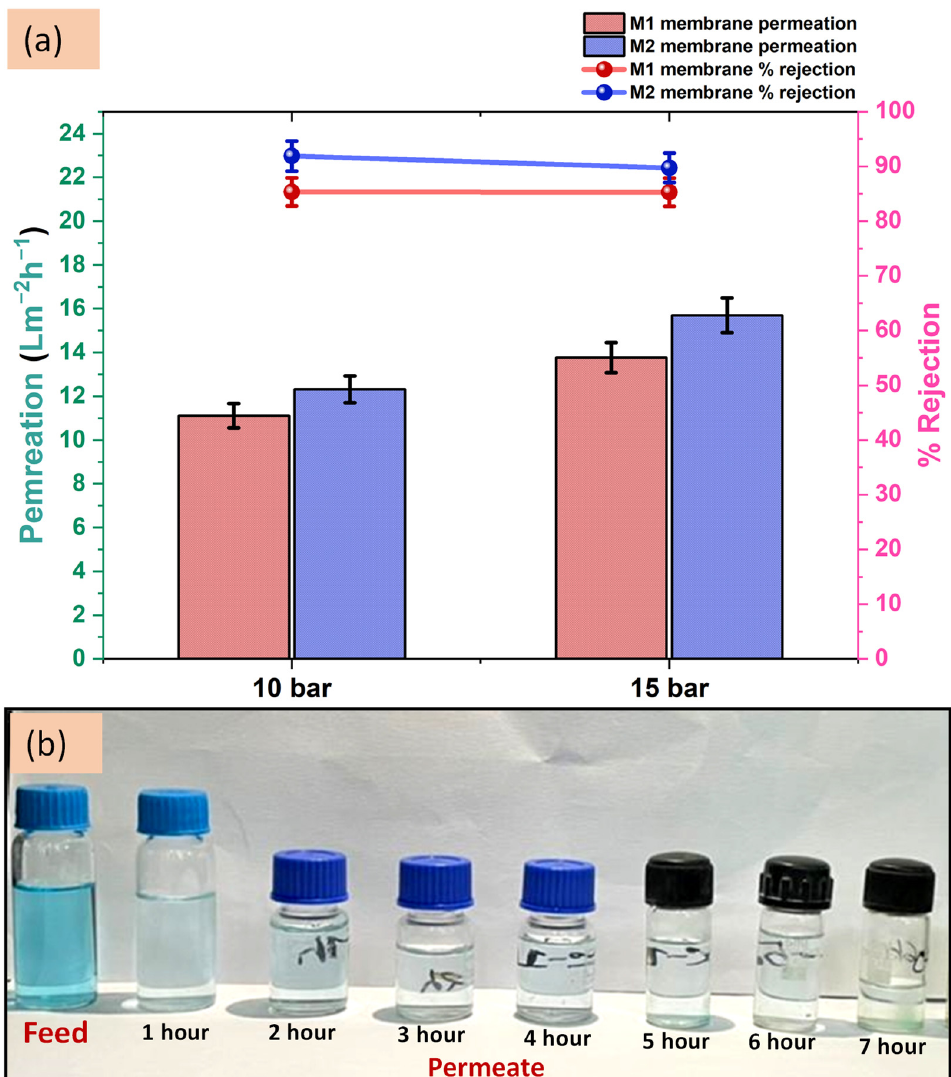
Figure 9. ( a ) M1 and M2 membrane’s permeation and rejection graphs against malachite green dye. ( b ) The images show the comparison of feed and obtained permeate per hour up to 7 h.